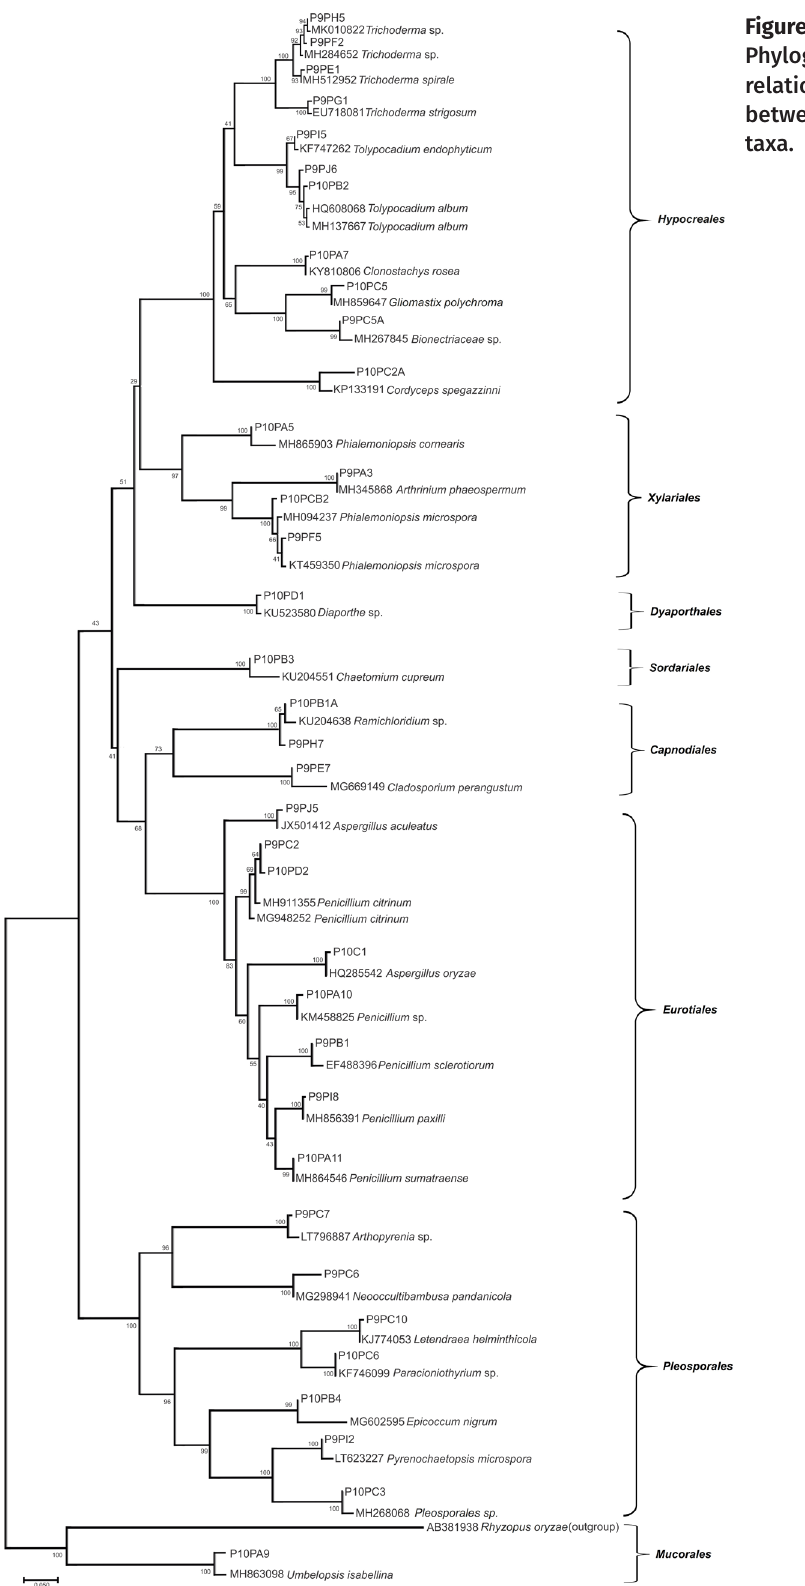
Figure 2. Phylogenetic relationship between fungal